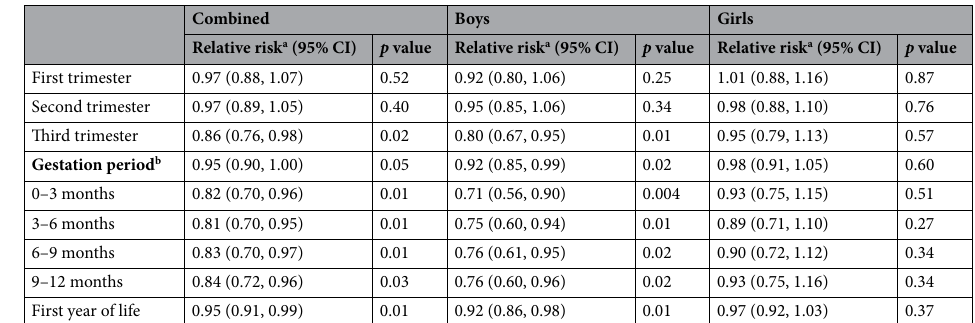
Table 2. Adjusted relative risk (95% CI) per 100 kJ m −2 increase in total erythemal UVR dose during early life for type 1 diabetes developed by age 16 years in children born in Western Australia between 1980–2014. a Models adjusted for ethnicity, maternal age, maternal diabetes, birth weight, parity, IEO, IRSD, caesarean section and gestational age at birth. Gestation models also adjusted for complications during pregnancy. b Trend in gestation trimester (total erythemal UVR dose for first, second and third trimester combined).